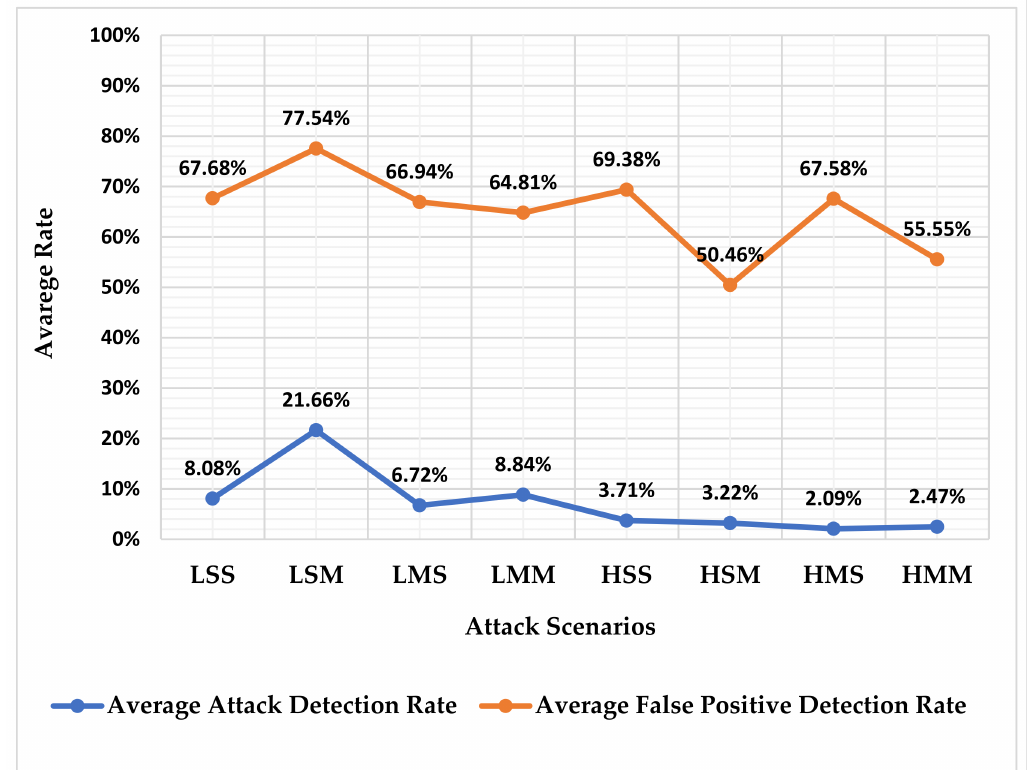
Figure 6. Average enhancement of proposed approach compared with entropy method using all simulation